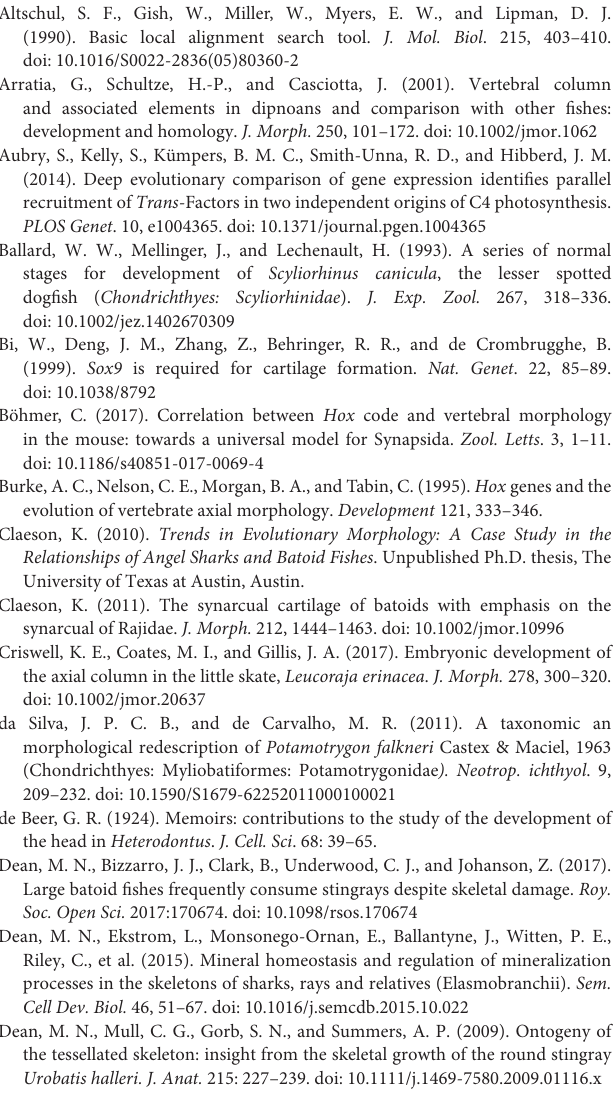
Figure S1 | Multiple sequence alignments of HoxC-like proteins. Amino-acid sequence alignments of the putative Leucoraja erinacea HoxC proteins with their Conditional Reciprocal Best Blast hit and HoxC proteins identified in other shark species. Identical residues are shown a s solid red blocks with white text, while residues with more than 70% similarity in physico-chemical properties are shown as red text and framed in blue. A, HocC4: NP_705897.1, Homo sapiens CRBB hit; TRINITY_DN27817_c0_g2 and TRINITY_DN30588_c0_g1, Leucoraja erinacea . B., HoxC6: NP_710160.1, Homo sapiens CRBB hit; Hetze0000001,